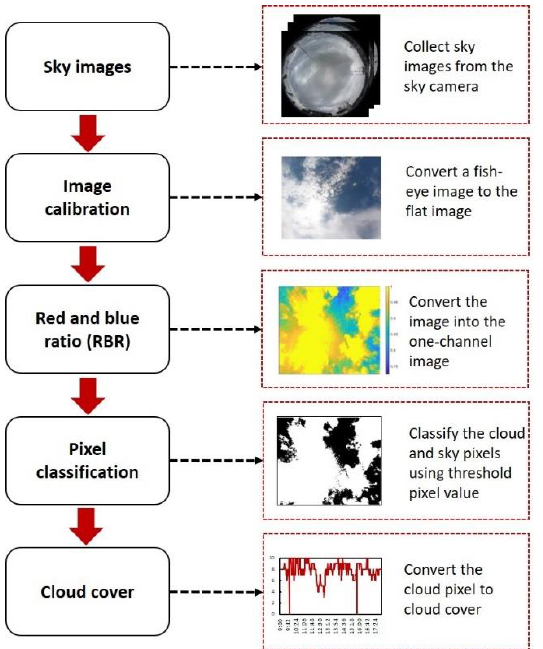
Figure 5. Flow chart for determining cloud cover using red, green, and blue (RGB) channels of an image.